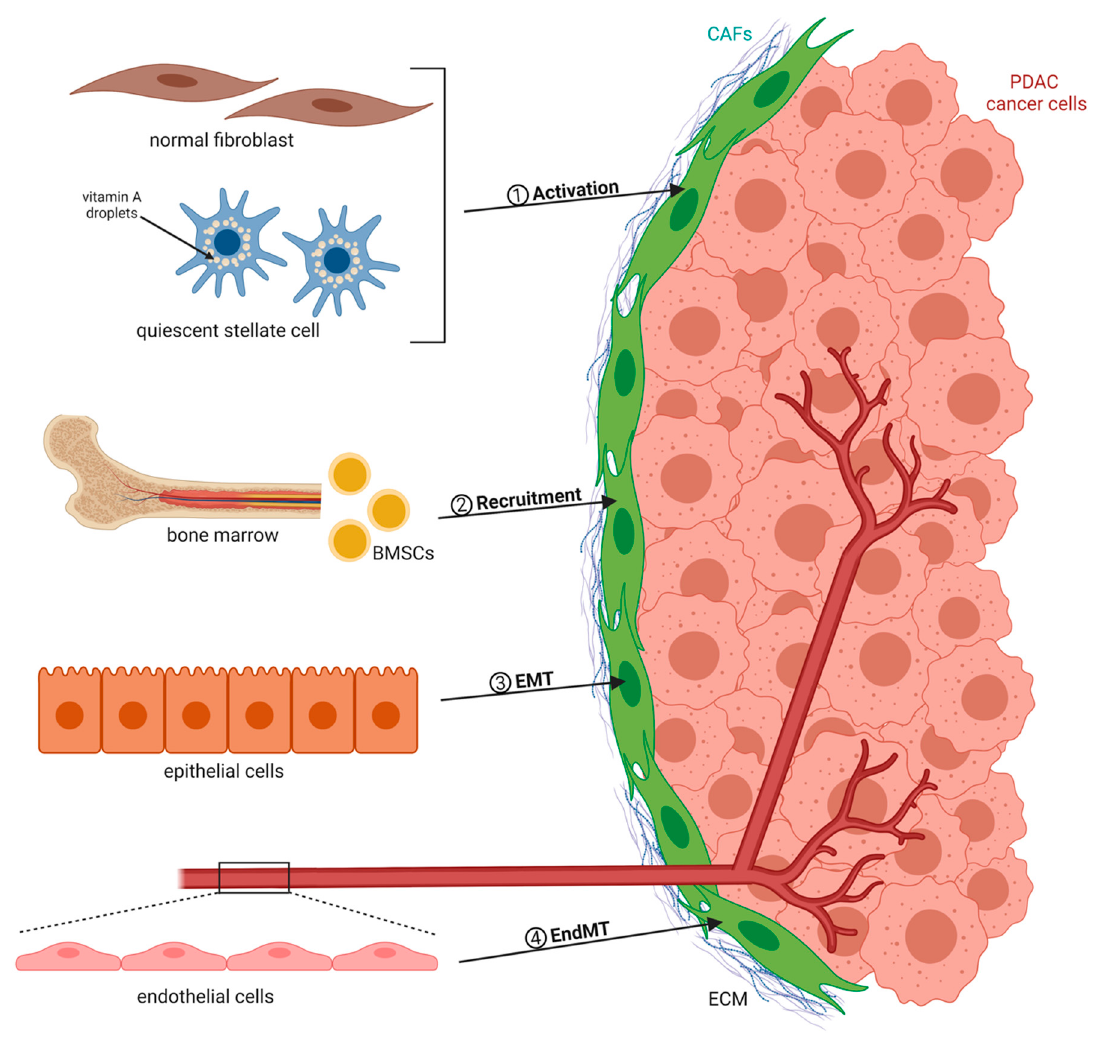
Figure 1. Heterogenous sources and activation mechanisms of cancer-associated fibroblasts (CAFs). CAFs can originate from pre-existing fibroblasts and quiescent stellate cells (via activation), bone marrow-derived mesenchymal stem cells (BMSCs) (via recruitment), epithelial cells (through epithelial-to-mesenchymal transition (EMT)), as well as from endothelial cells (through endothelial-to-mesenchymal transition (EndMT)). Abbreviations: pancreatic ductal adenocarcinoma (PDAC); extracellular matrix (ECM).